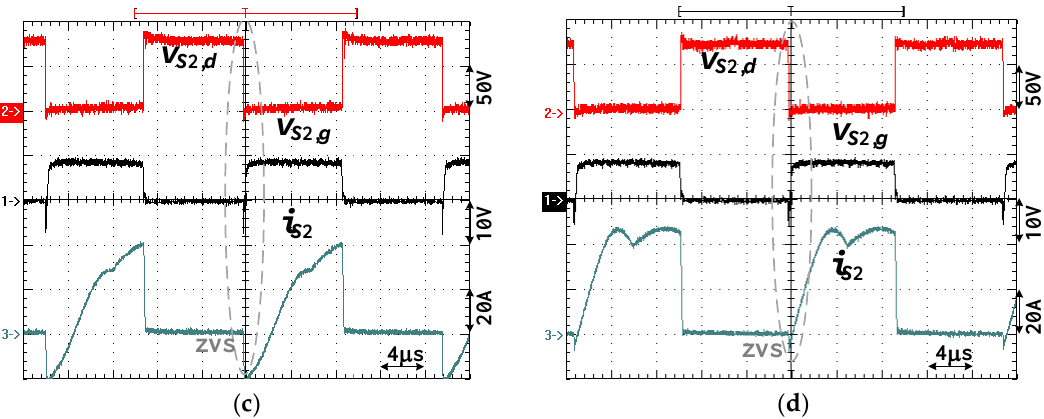
Figure 11. Experimental results of power switches S 1 and S 2 under high voltage mode operation and V in = 41 V: ( a ) v S 1 , g , v S 1 , d , i S 1 at 20% rated power; ( b ) v S 1 , g , v S 1 , d , i S 1 at 100% power; ( c ) v S 2 , g , v S 2 , d , i S 2 at 20% rated power; ( d ) v S 2 , g , v S 2 , d , i S 2 at 100% power.